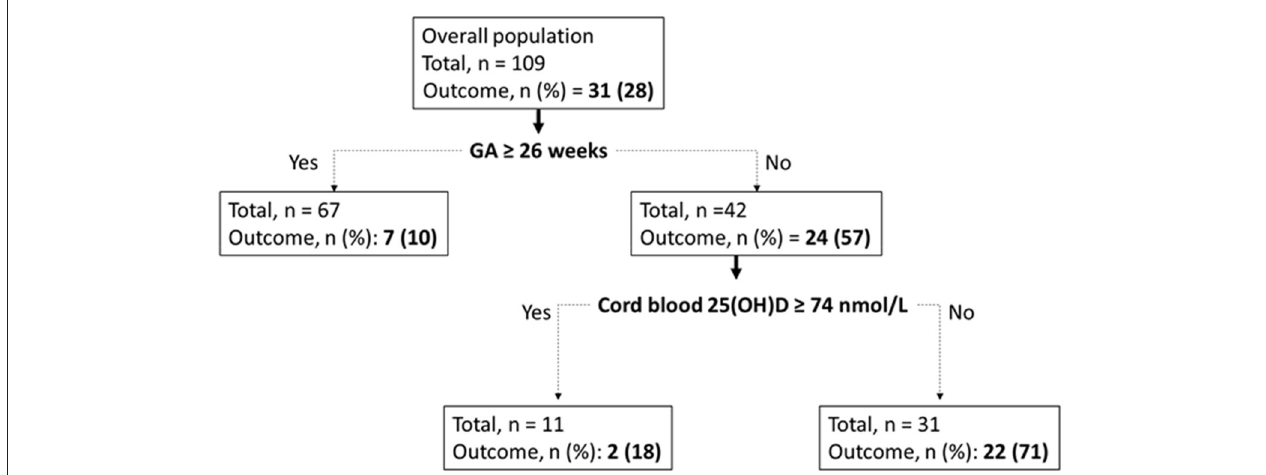
FIGURE 2 | CART model for death or MV DoL7 outcome. In each node (rectangle), the category “Outcome” refers to the presence of the combined outcome of death or MV DoL7, with n and percentage of related infants.